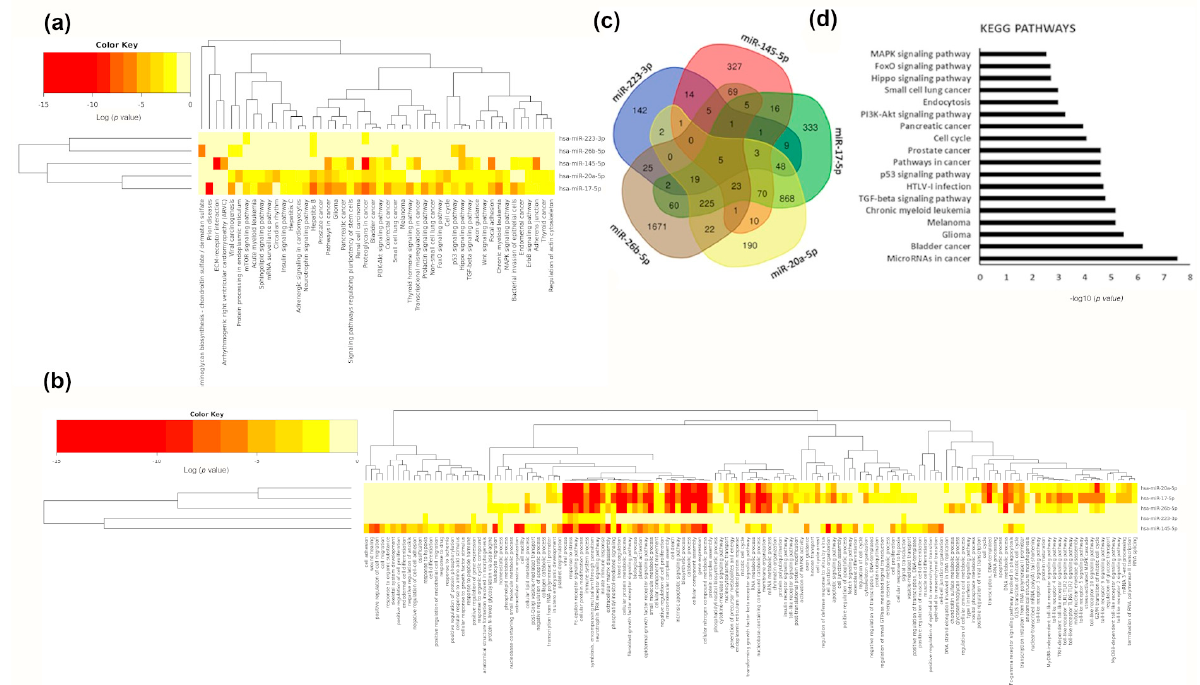
Figure 6. Functional analyses of modified macrophage microRNAs. ( a ) Cluster heat map of KEGG pathways significantly enriched among modulated macrophage microRNAs. ( b ) Cluster heat map of GO biological processes significantly enriched among modulated macrophage microRNAs. The colour bar represents –log 10 of the enrichment p -value after FDR correction. ( c ) Venn diagram showing common targets of the modulated microRNAs. ( d ) Bar chart of the most represented KEGG pathways (FDR adjusted p -value < 0.01) of the predicted and validated targets of modified macrophage microRNAs. X-axis represents –log 10 of the enrichment p -value after FDR